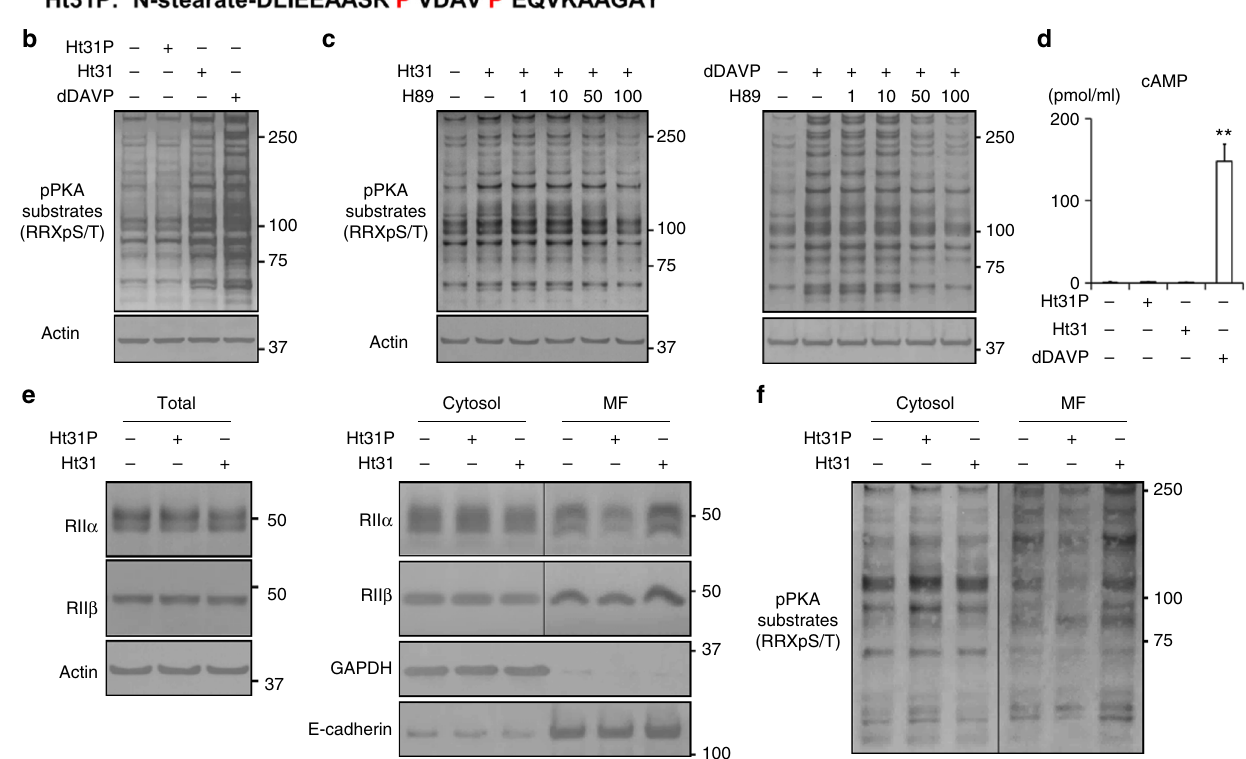
Fig. 1 Ht31 increases PKA activity without elevation of cAMP. a The sequences of Ht31 and Ht31P. Ht31 and Ht31P are stearated at the N-terminus to increase cell membrane permeability. b The increase in PKA activity by Ht31. Ht31P (50 µ M), Ht31 (50 µ M), or dDAVP (1 nM) was added to the basolateral side of the mpkCCD cells for 1 h. Representative blots of three independent experiments are shown. c Dose-response studies of H89. Ht31 (50 µ M) or dDAVP (1 nM) was added in the presence or absence of H89 (1 – 100 µ M) for 1 h. The mpkCCD cells were pretreated with H89 for 1 h before Ht31 or dDAVP stimulation. Representative blots of three independent experiments are shown. d No signi fi cant elevation of cAMP concentration in response to Ht31. The mpkCCD cells were treated with Ht31P (50 µ M), Ht31 (50 µ M), or dDAVP (1 nM) for 1 h. Bars are mean values ± SD of three experiments. Asterisk indicates a signi fi cant difference compared with control. Tukey, ** p < 0.01. e , f The effects of Ht31 on PKA localization and activity. Ht31P (50 µ M) or Ht31 (50 µ M) was added to the basolateral side of the mpkCCD cells for 1 h. The mpkCCD cells were then incubated with 1% Triton X-100 for 3